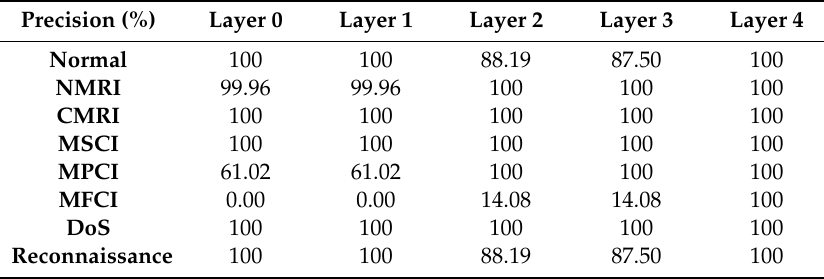
Table 3. Precision of the Clustering Results for Each Class In Each Hidden Layer.